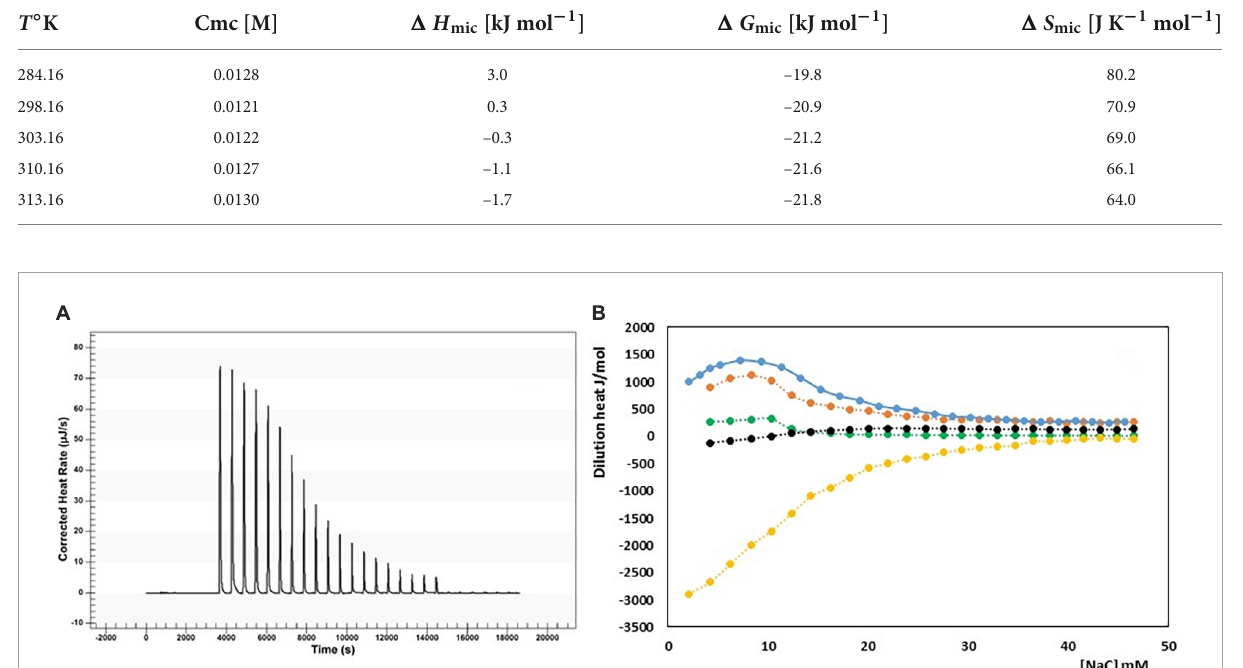
TABLE 1 Cmc and thermodynamic parameters for micelle formation, obtained from ITC experiments, as a function of temperature for NaC.